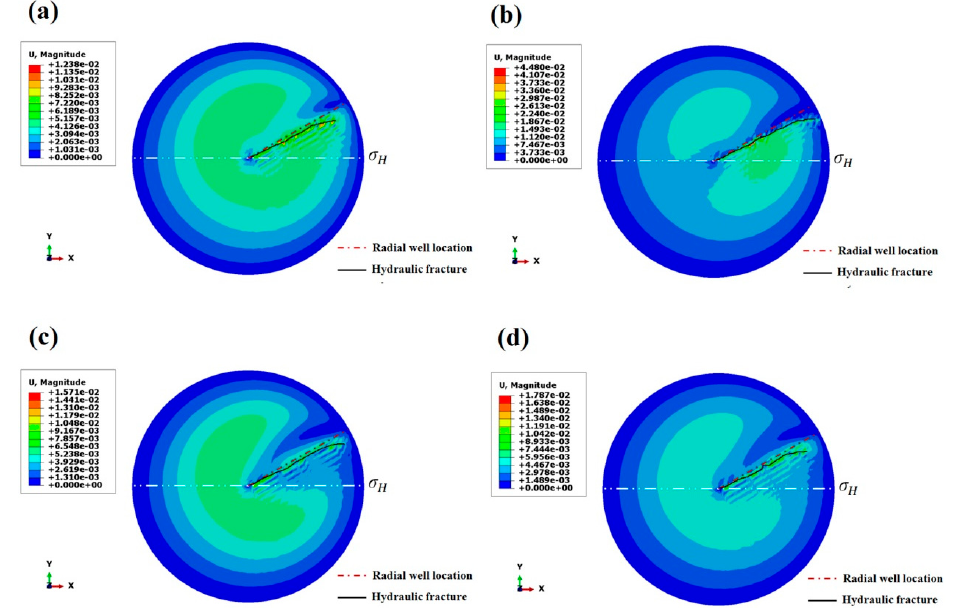
Figure 13. Simulation results of hydraulic fracture propagation guided by a single radial well under different fracturing fluid viscosities: ( a ) 1 mPa·s; ( b ) 50 mPa·s; ( c ) 100 mPa·s; and ( d , b ) 150 mPa·s.